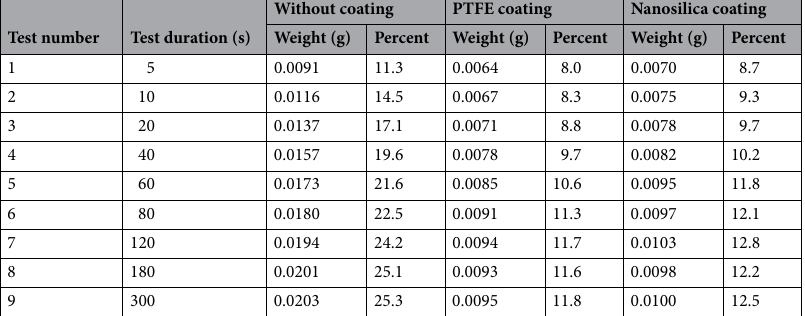
Table 3. Asphaltene deposition on uncoated, PTFE-coated and nanosilica coated electrodes for different exposure times to electric field. Deposition value (electric field strength 2 kV/cm, 4% toluene concentration, 2000 ppm asphaltene concentration, static state).